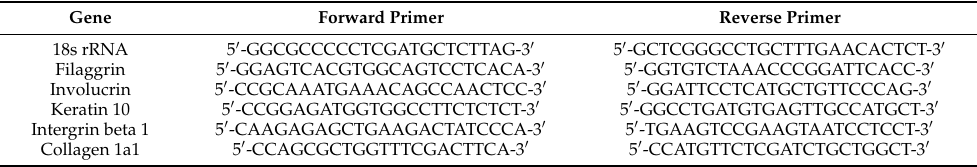
Table 1. Sequences of forward and reverse primers used for qPCR analysis of gene expression